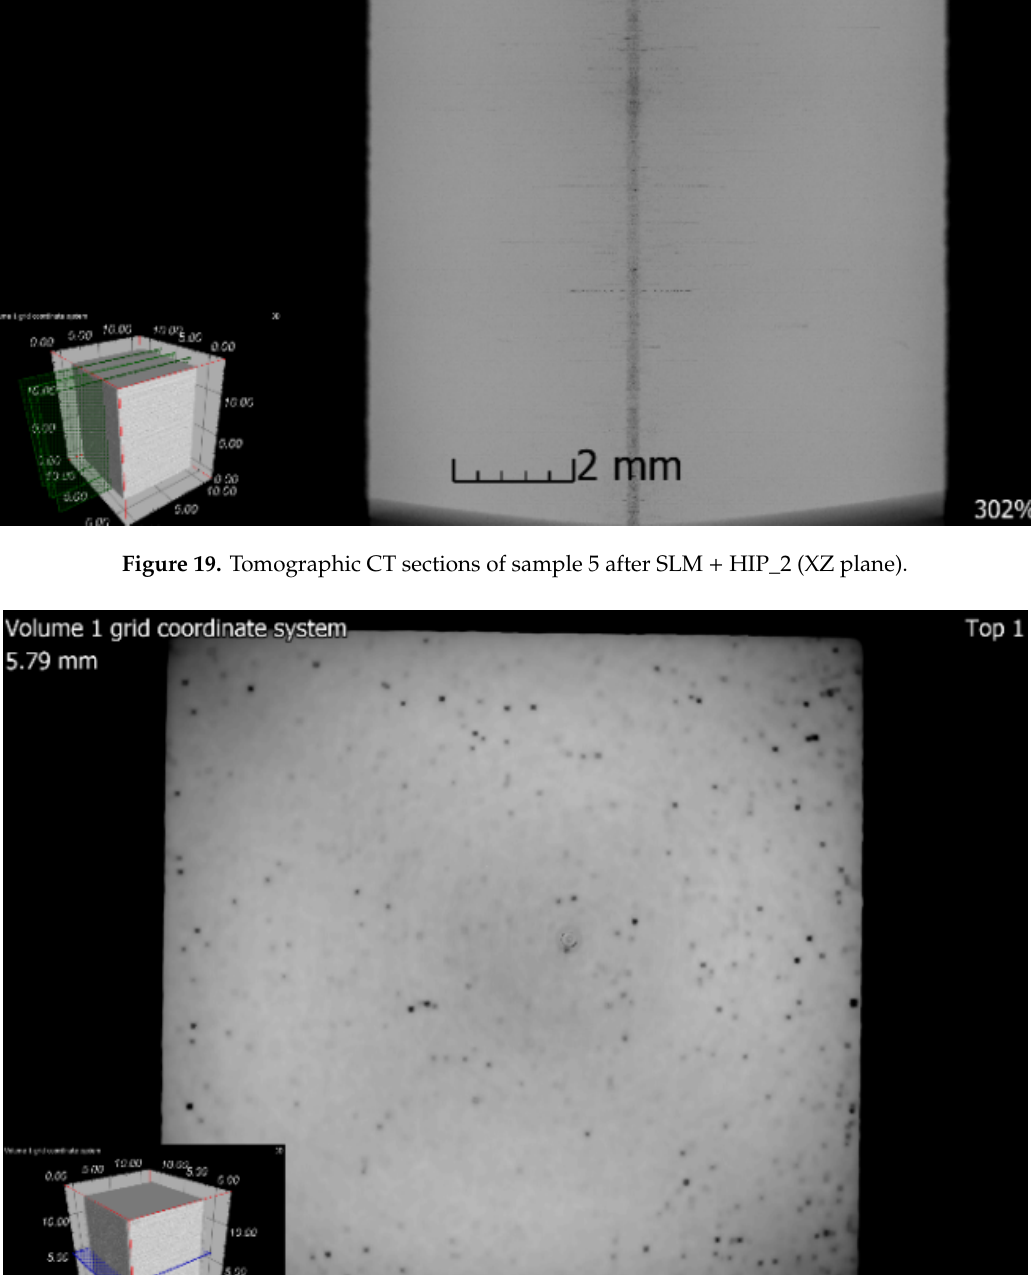
Figure 20. Tomographic CT sections of sample 5 with an adaptive Gaussian filter.